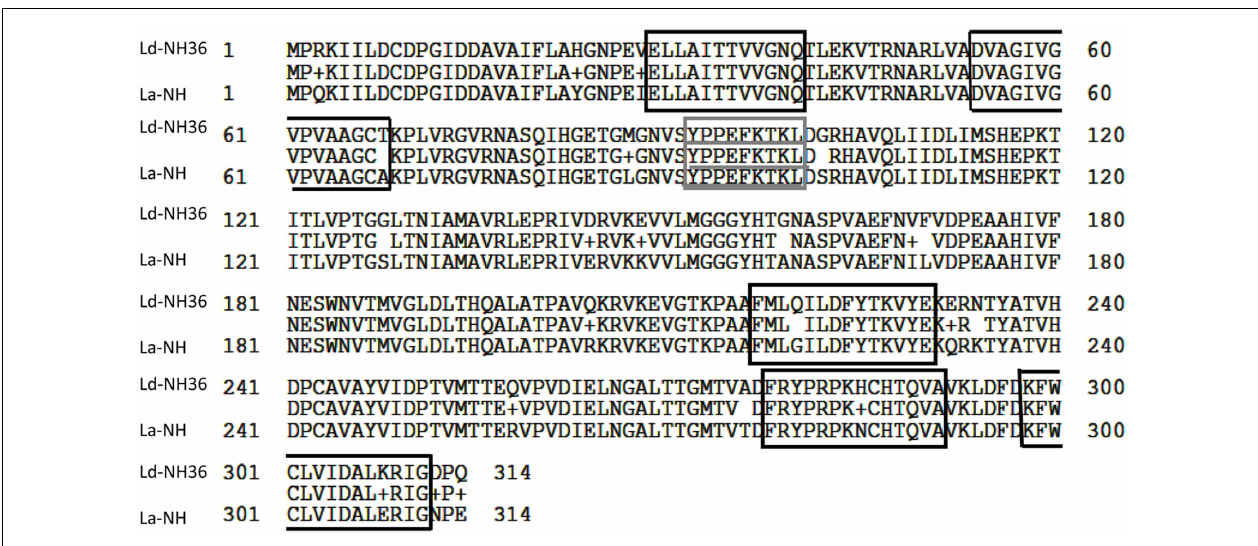
FIGURE 6 | Sequence analysis of nucleoside hydrolases of Leishmania donovani and Leishmania amazonensis. The sequences of the nucleoside hydrolases NH36 of L. donovani (Ld-NH36) and A34480 of Leishmania amazonensis (La-NH) were aligned using the BLASTP GenBank program.The line in the middle of the two sequences shows the